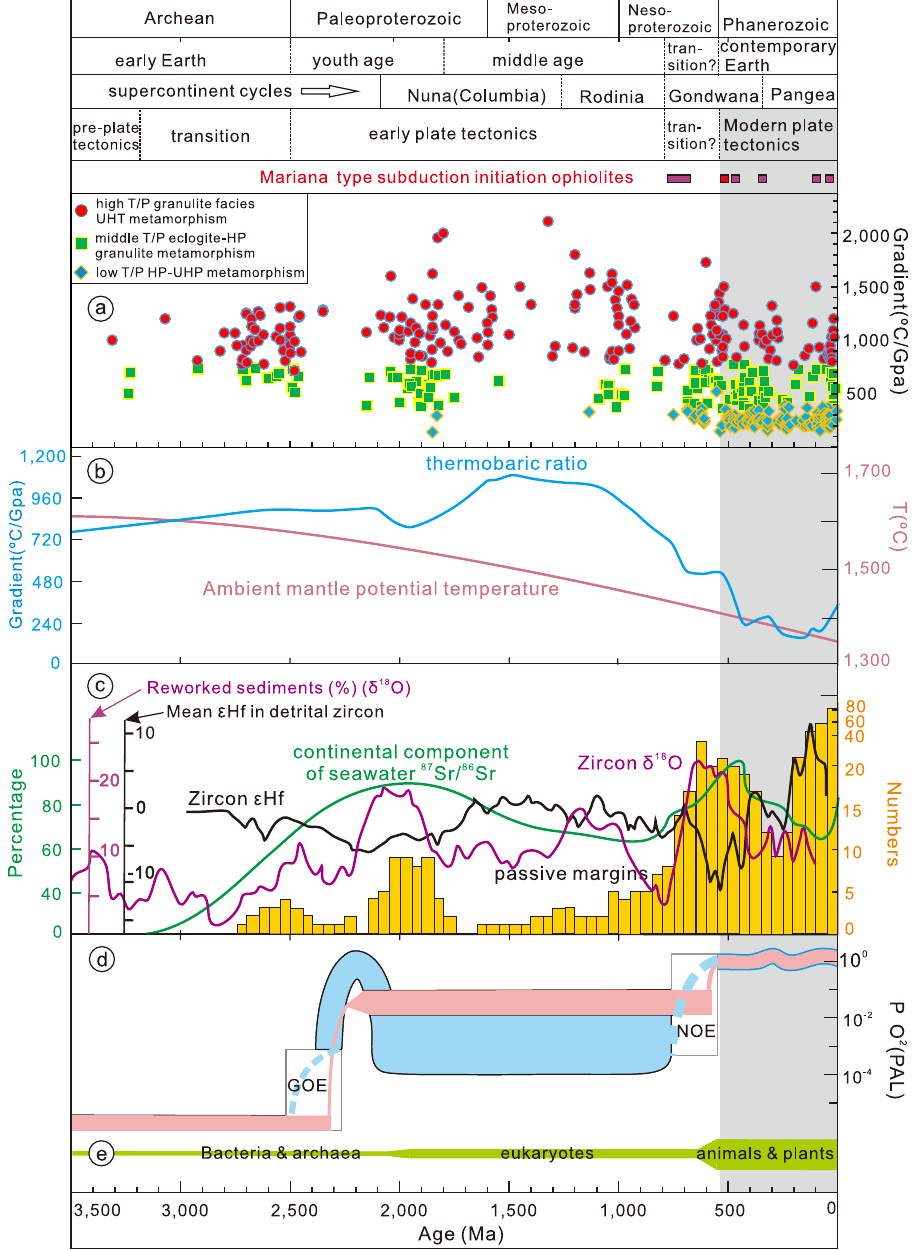
Fig. 1 Stages of geodynamic regimes with respect to ages of Mariana-type subduction initiation ophiolites and evolution of Earth ’ s geological and sur fi cial proxies. a The thermal gradient vs. metamorphic ages of three main types of granulite facies metamorphism 1 . b The inferred mantle potential temperature 5 , thermobaric ratio curve 21 . c The running mean of initial ε Hf in detrital zircons and the running mean of zircon δ 18 O normalized to average sediment 26 , the ages of ancient and modern passive margins 74 , the normalized seawater 87 Sr/ 86 Sr curve 75 . d The changing oxygen levels within the atmosphere relative to the present atmospheric level 76 , and the evolution of life within the biosphere 77 . Gray shaded bar corresponds to the Phanerozoic